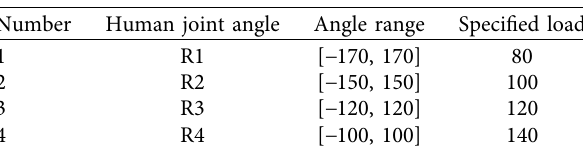
Table 1: Parameters of the human virtual experiment system.